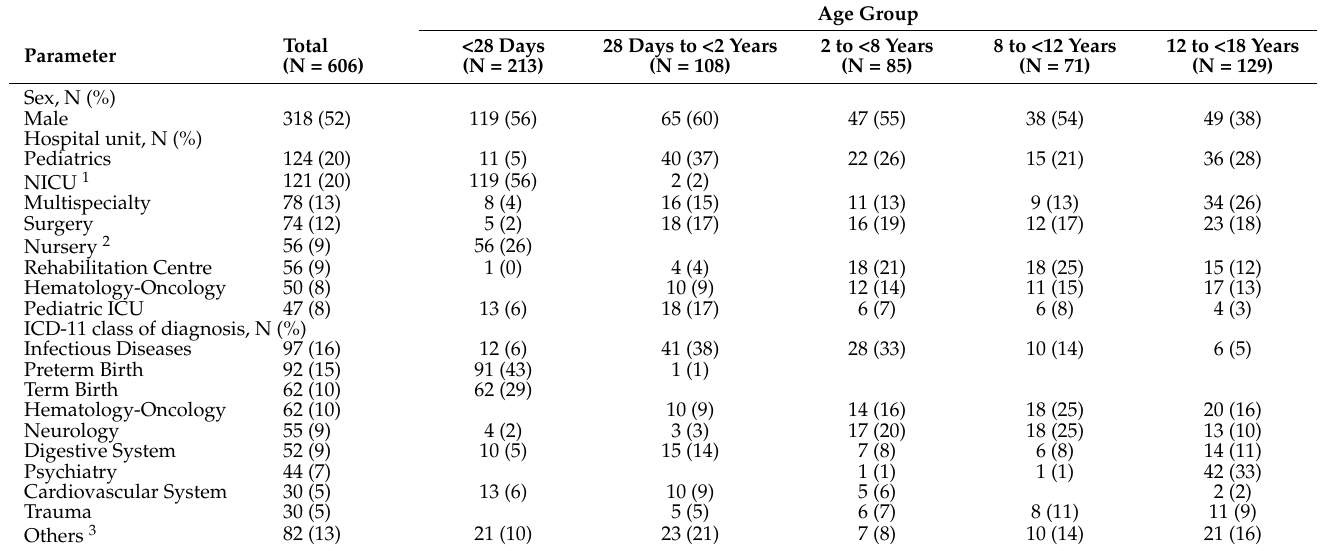
Table 3. Active prescriptions for the total population (N = 606).